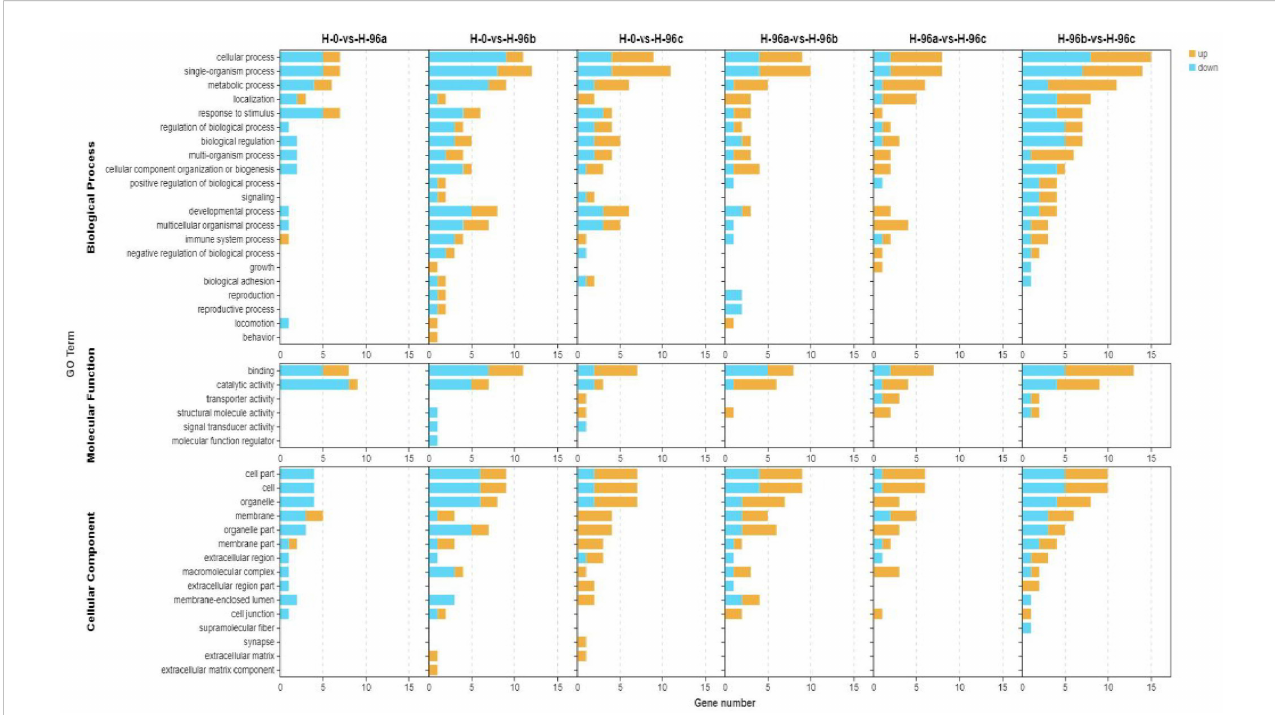
FIGURE 6 GO enrichment analyses of differentially expressed genes (DEGs) in hemolymph transcriptome. H-0: Control group; H-96a: concentration of 20 mg/L group; H-96b: concentration of 50 mg/L group; H-96c: concentration of 100 mg/L